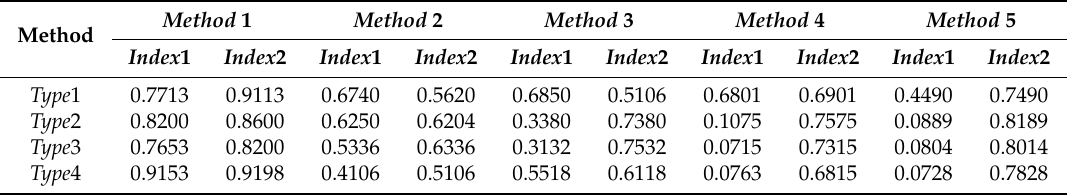
Table 4. Average results of Index 1 and Index 2 for different situations.